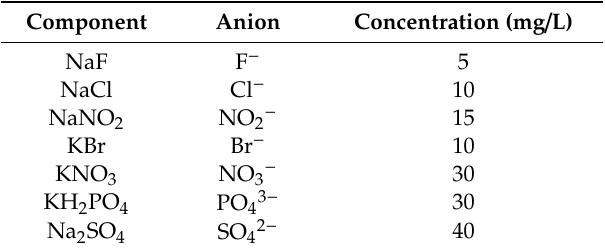
Table 1. Composition of reference